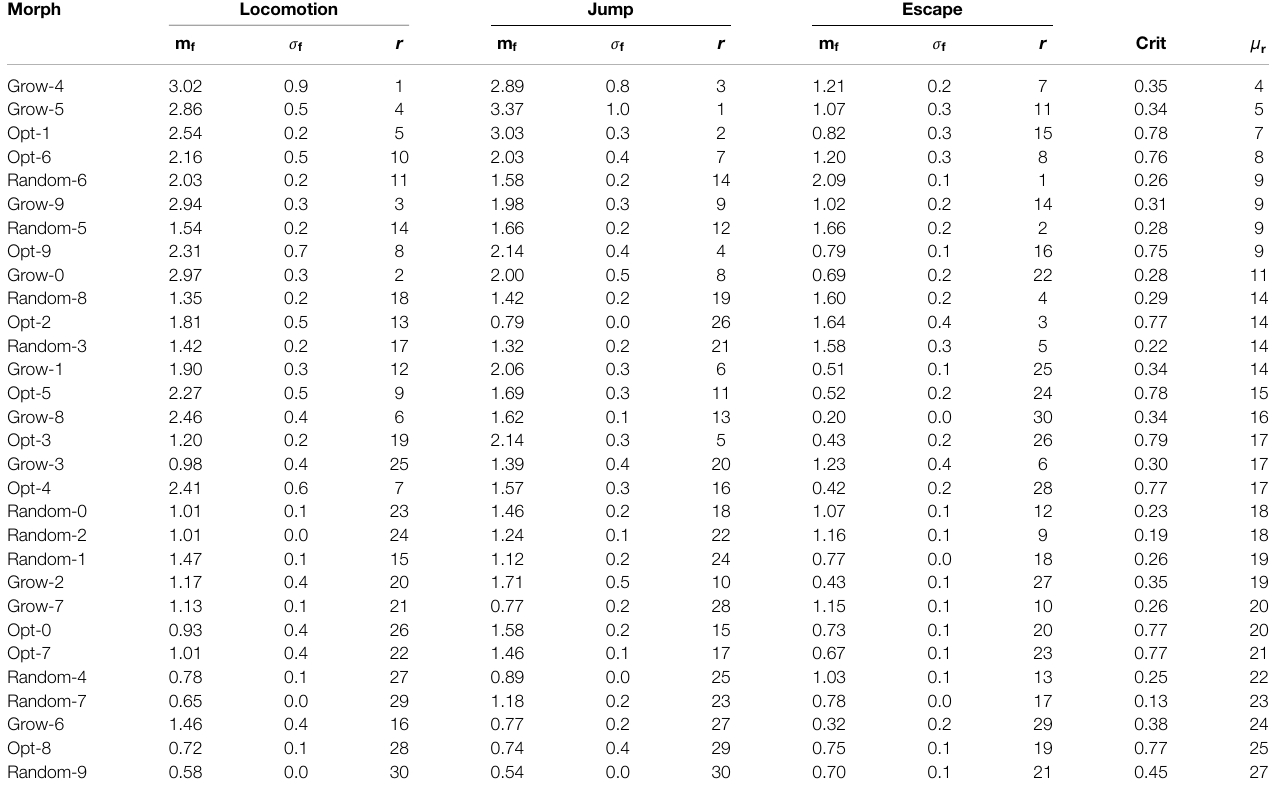
TABLE 2 | Results for the optimized and randomly generated morphologies coupled with the phase controller. For each task and each morphology, the table shows the median m f and the standard deviation σ f of f across all the 10 runs. Moreover, the table also shows the task-wize ranks r , the average rank μ r , and the criticality of each morphology. Morph Locomotion Jump Escape